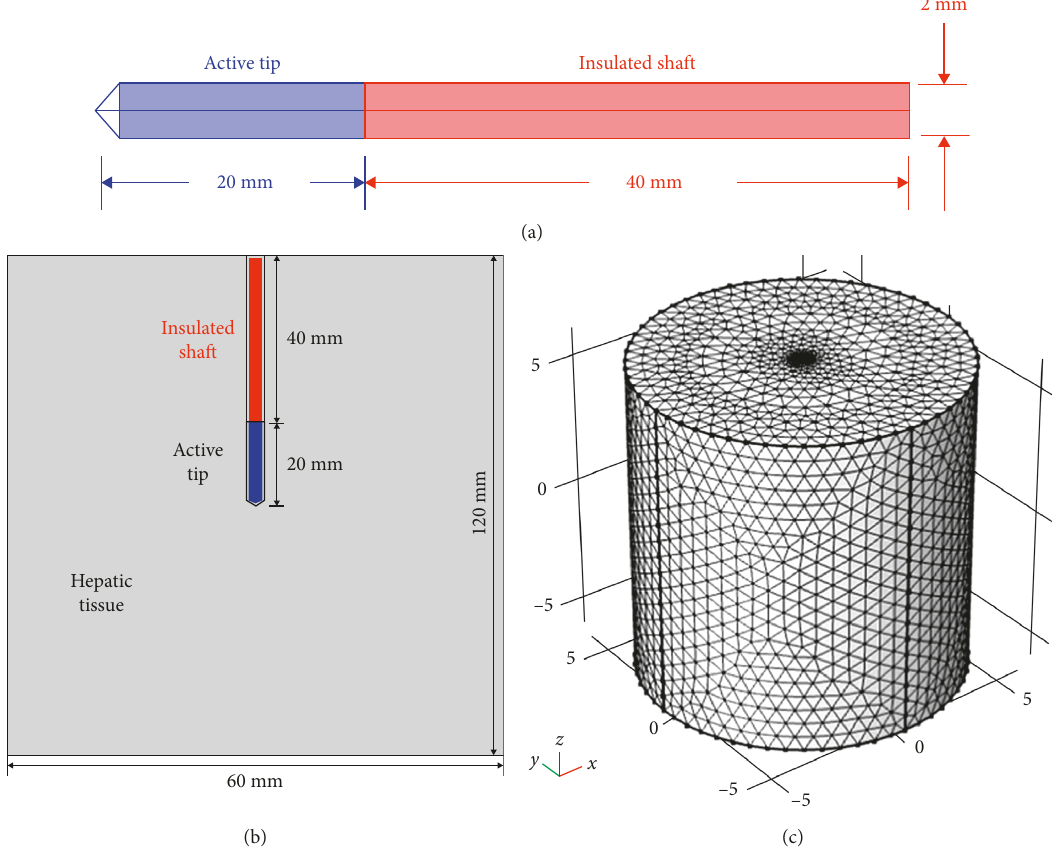
Figure 1: (a) Schematic of magnetic heating probe. The probe is a cannula with two main parts: a distal active tip made of a nanocomposite (blue) and a proximal insulated shaft (pink). Therapeutic treatment is achieved when the active tip is brought in contact with the target area and exposed to alternating magnetic field. (b) Schematic of the geometry model (cylindrical block: diameter, 6cm; height, 12cm), showing the cross section of the probe inserted in the tissue. (c) The 3D meshed model of the cylindrical